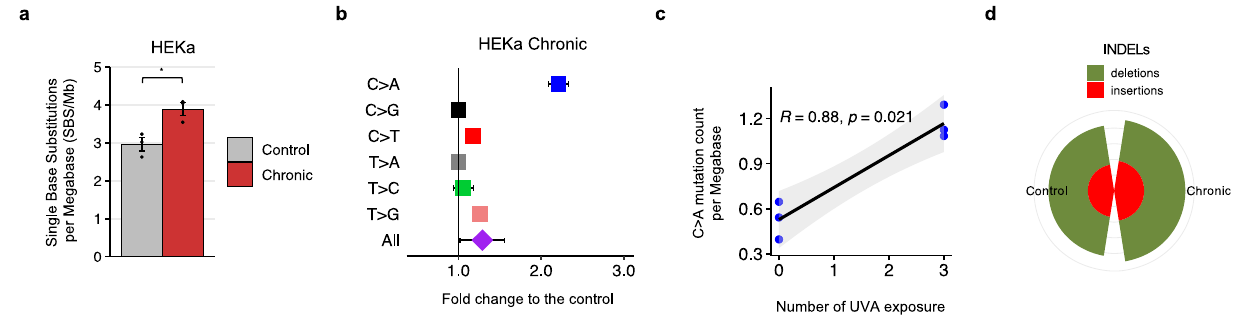
Fig.6|MutationanalysisofHEKacellsirradiatedbyaUV-naildryer.a Mutation count per megabase (Mb) detected in the different conditions, represented in colors, inHEKacells.Data ispresented as a meanvalue ± standard error from n = 3 independent biological replicates. b Fold increase of single base substitutions in UV-treated clones compared to controls. Fold increase is expressed as mean fold- change ± SE(standarderror) from n =3 independent replicates. c Spearman ’ s rank correlations between the number of C>A substitutions and the number UV